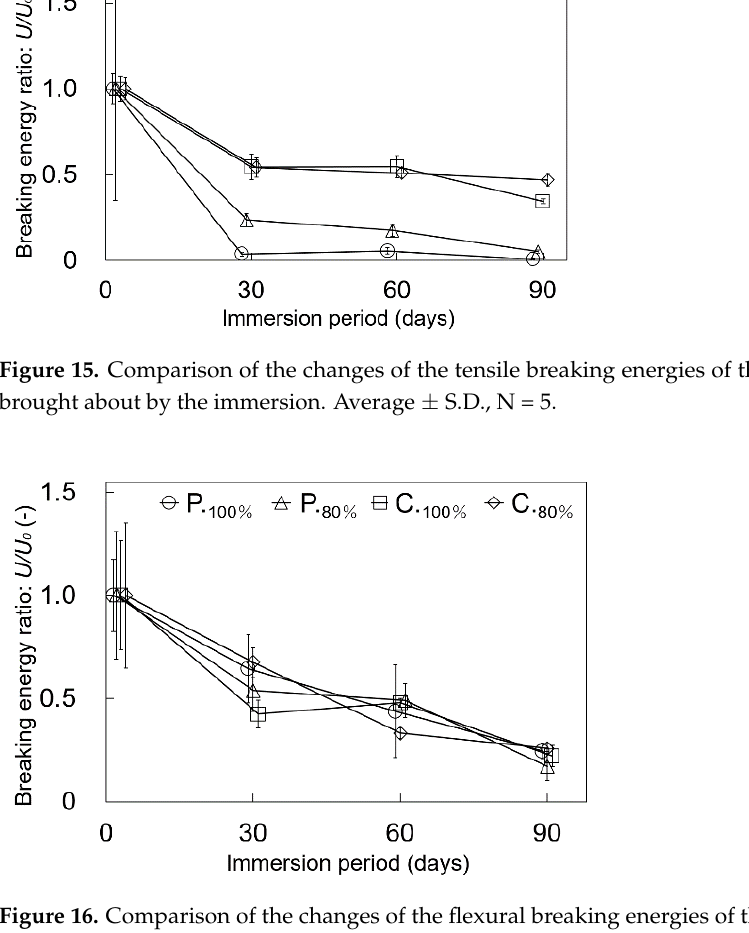
Figure 15. Comparison of the changes of the tensile breaking energies of the four test piece types brought about by the immersion. Average ± S.D., N = 5.